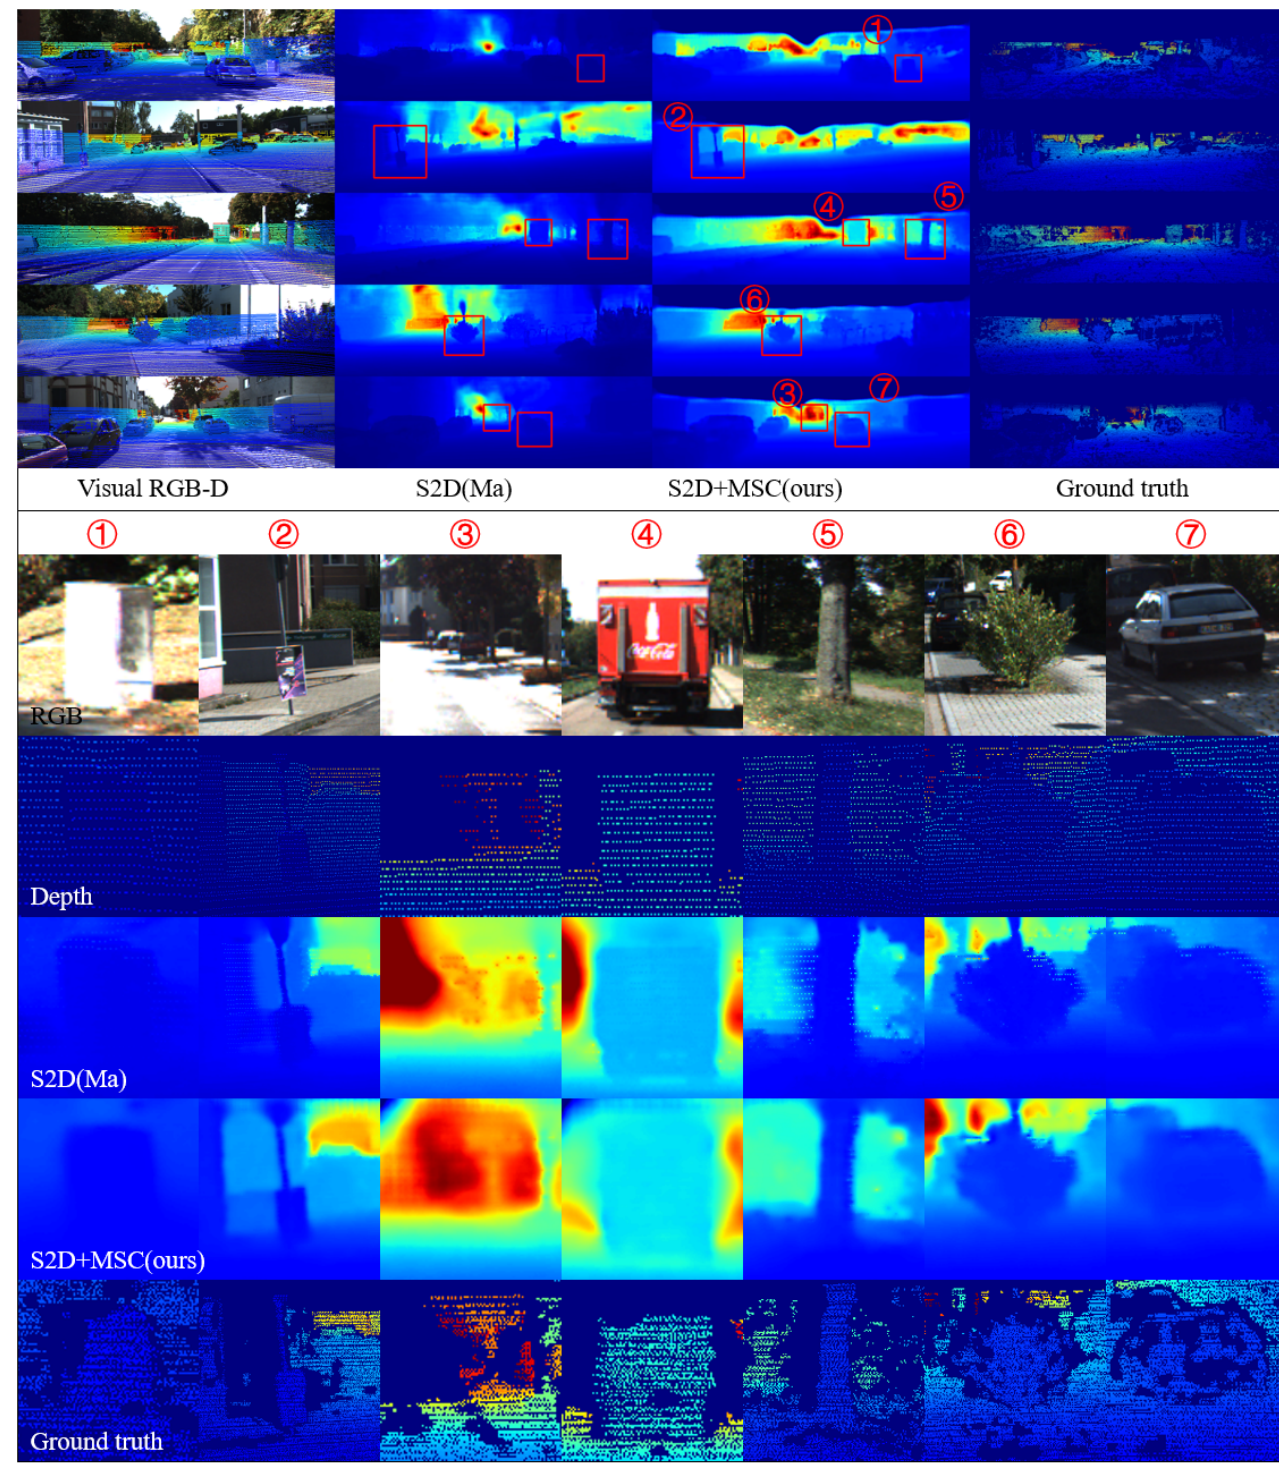
Figure 6. Results of our self-supervised depth completion on the prediction